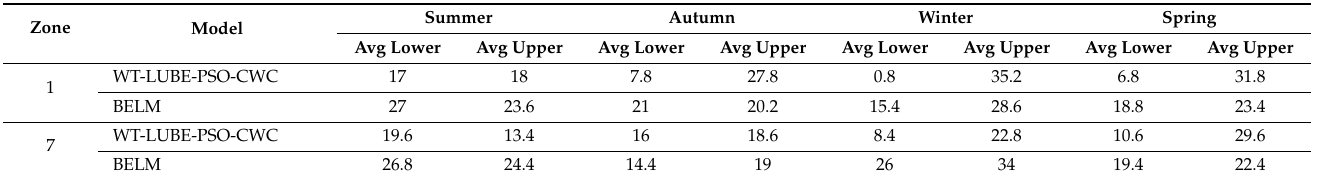
Table 16. Average number of observations below the lower limit and above the upper limit of the PIs for 0.9 confidence level. Zone